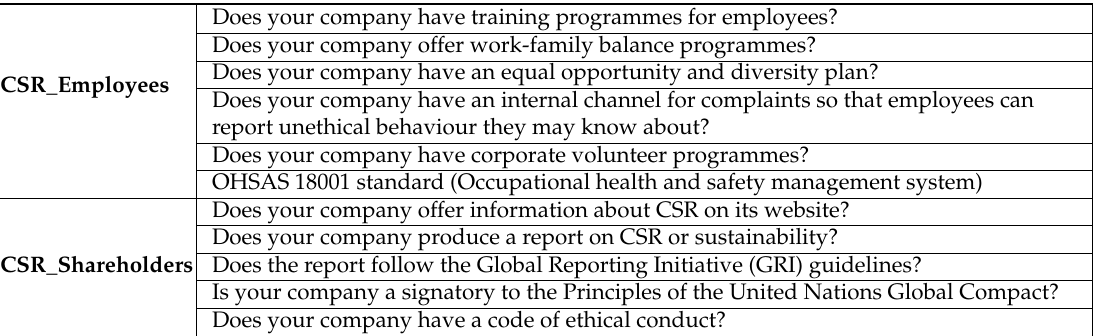
Table 2. Indicator of CSR Practices: Employees and